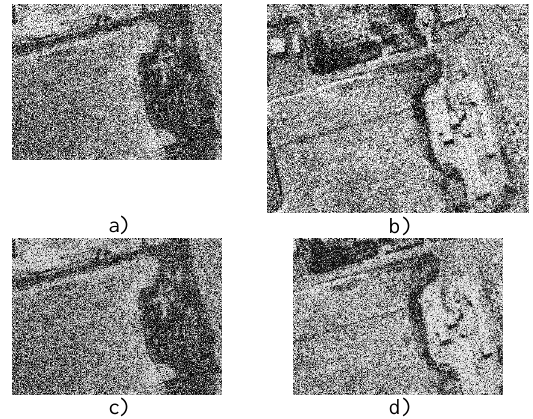
Figure 1. Example 1: a) etalon TV fragment; b) test IR